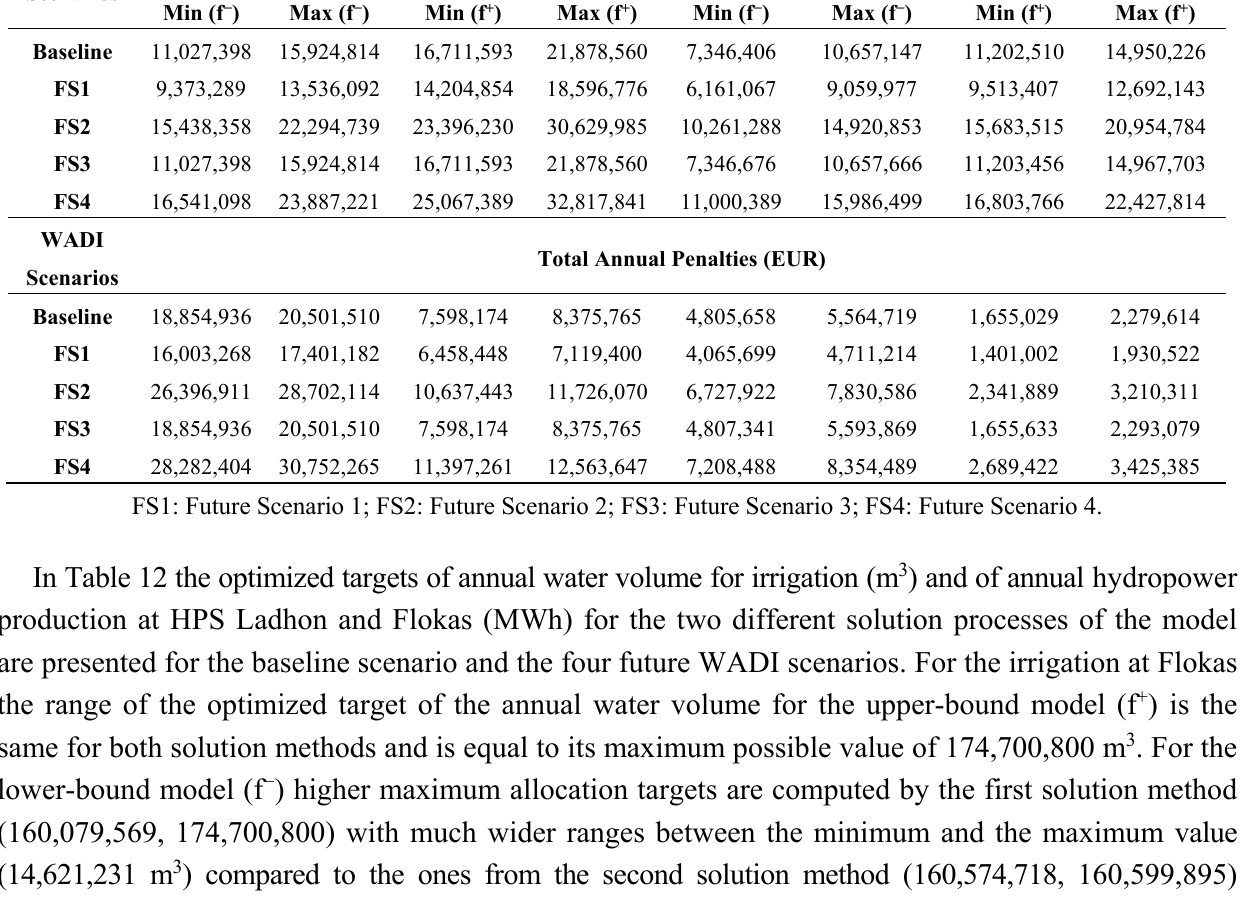
Table 10. Total annual benefit and penalties (EUR) for hydropower production at Ladhon HPS. WADI